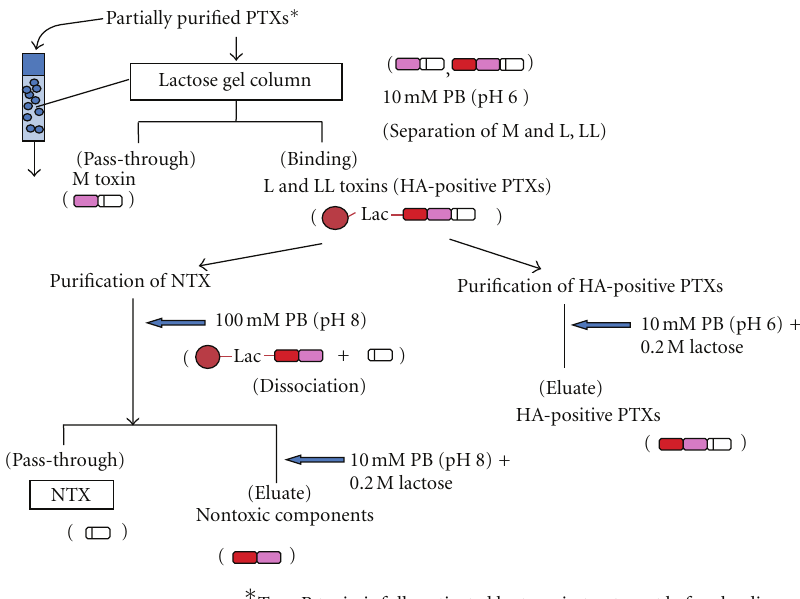
Figure 2: Simple procedure for purifying type A and B NTXs. Partially purified type A HA-positive PTXs (L and LL) or trypsin-treated (fully activated) type B L toxin was layered on a lactose gel column under acidic conditions (pH 6.0). After washing, the pH was adjusted